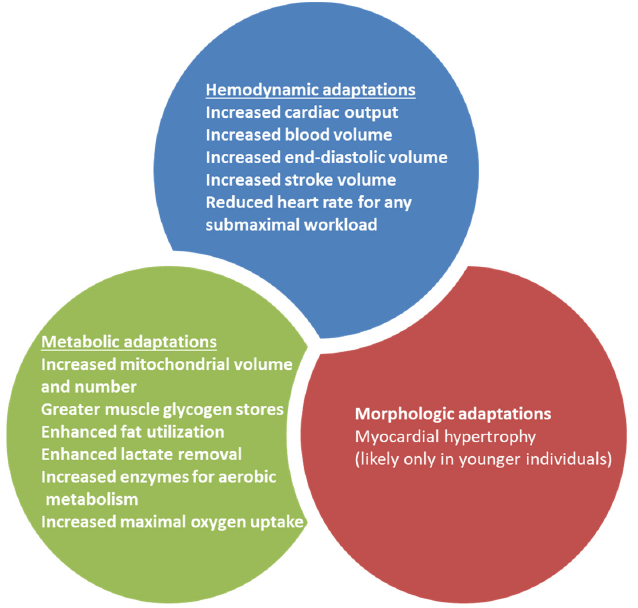
Figure 2. Physiologic adaptations to physical training in humans. Physical training involves hemo- dynamic, metabolic, and morphologic